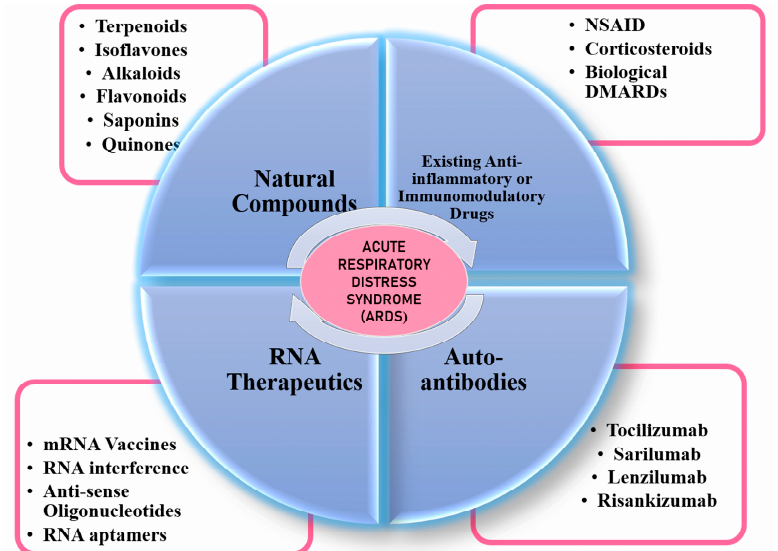
Figure 5. A schematic representation of different classes of immunomodulatory drugs that can be used against ARDS.